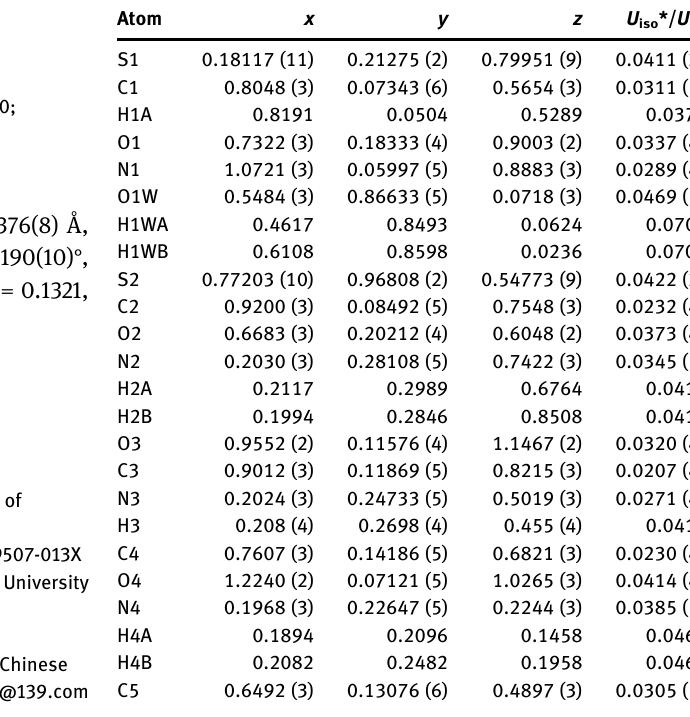
Table  : Fractional atomic coordinates and isotropic or equivalent isotropic displacement parameters (Å 